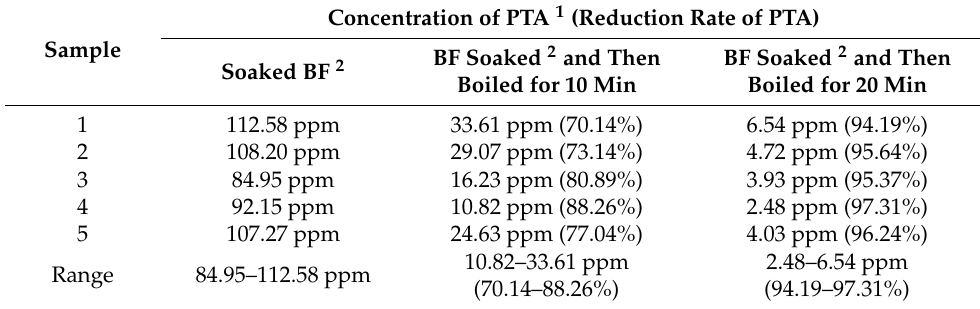
Table 1. Analysis of the concentration of PTA in BF according to boiling time.